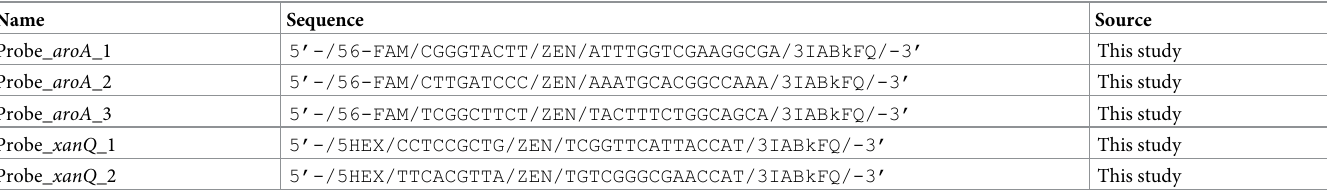
Table 2. List of probe